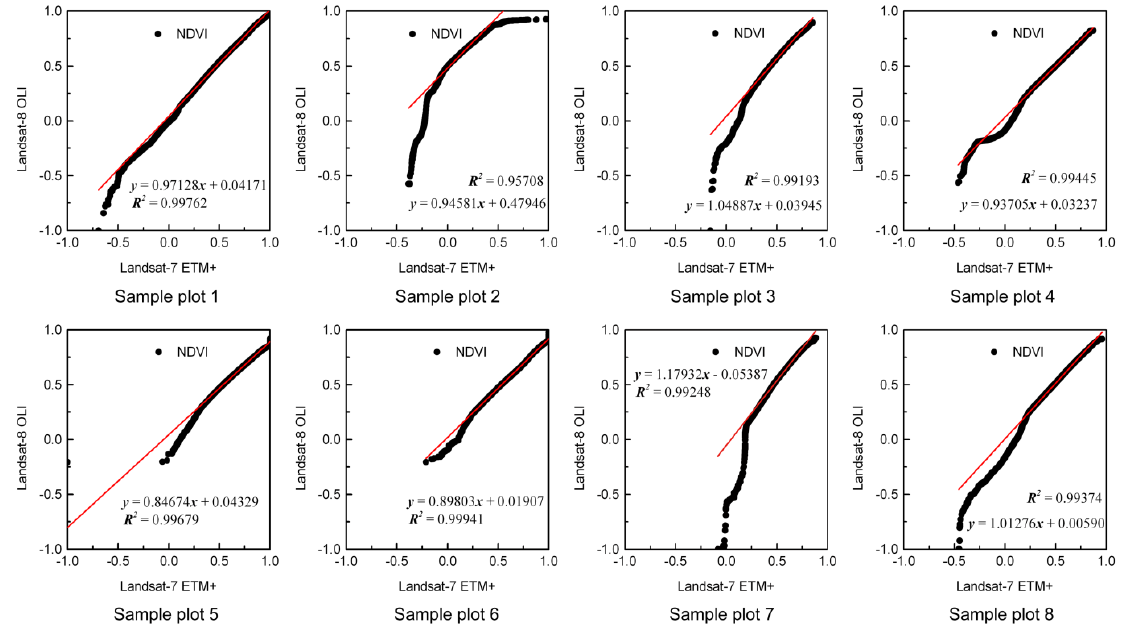
NDVI and MNDWI values deviated from the fitted curve in each plot of Figures 8 and 10. There were differences for the lower values of NDVI and higher values of MNDWI. Figure 8. Statistical relationship between Landsat-7 ETM+ and Landsat-8 OLI NDVI values for the eight sample plots. The linear regression equation and R 2 value are given in each plot. The red solid line refers to the linear fitting curve.